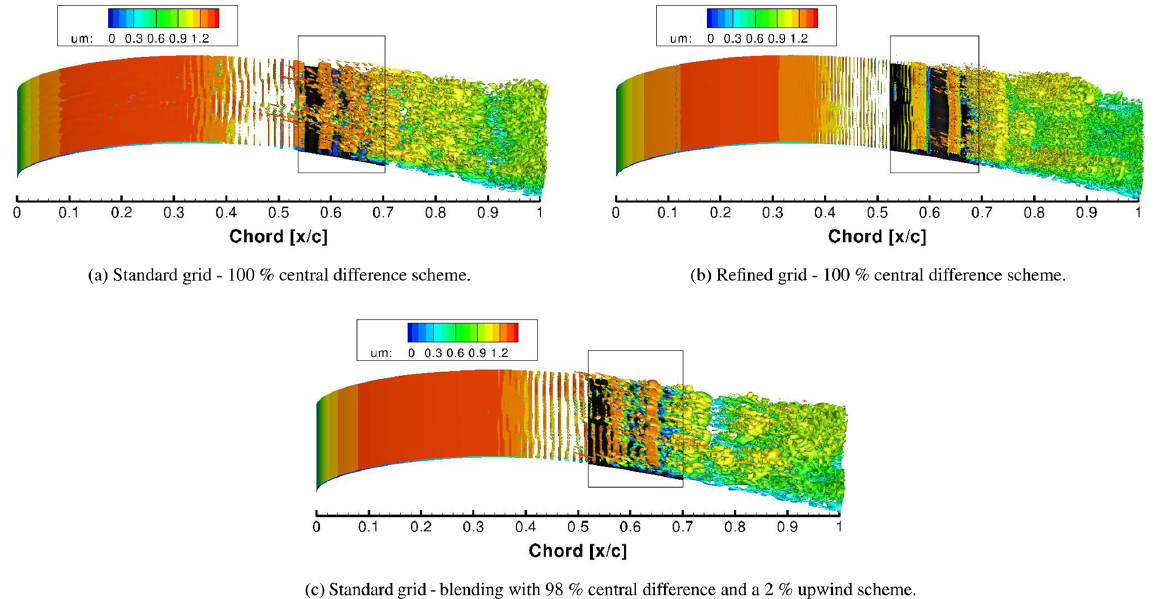
Figure 1. Instantaneous iso-surfaces of the Q criterion ( Q = 250) colored by the mean streamwise velocity normalized by u 2 ∞ /c 2 . The Q criterion is commonly used for vortex visualization and defines vortices as areas where the vorticity magnitude is greater than the mag- nitude of the rate of strain (Hunt et al., 1988). The black rectangle highlights the mean separation region, which is visualized below by the black iso-surface ( u mean = − 0 . 01) indicating negative mean velocity.